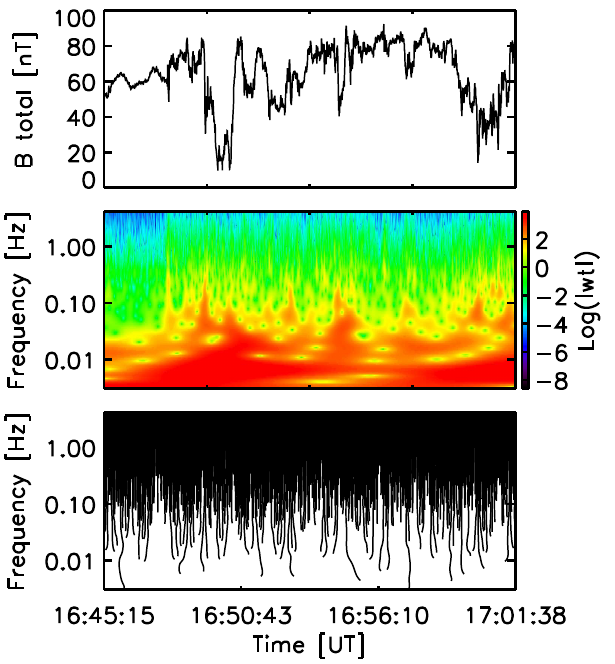
Fig. 2. Segment of data shown in Fig. 1 (top panel), its spectrogram (middle panel), and the map showing locations of the modulus max- ima (lower panel).